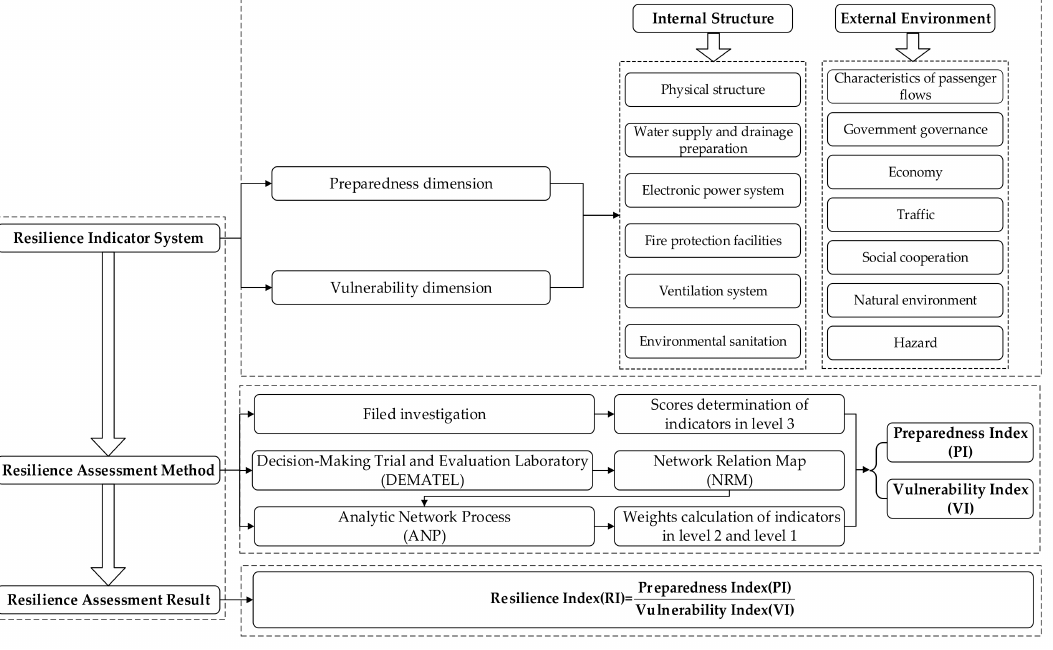
Figure 1. Resilience assessment